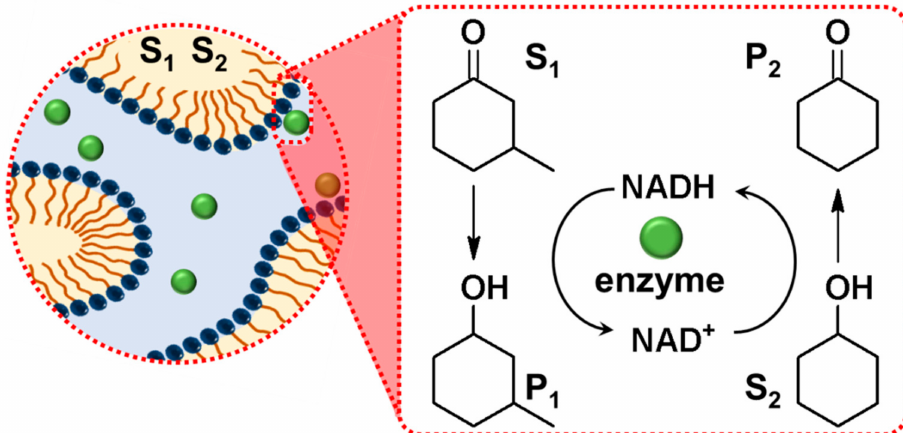
Figure 34. A horse liver alcohol dehydrogenase-catalyzed coupled coenzyme regenerating cycle in a water/isooctane or heptane µ em stabilized by sodium bis-(2-ethylhexyl)sulfosuccinate or pentaethylene glycol dodecyl ether,